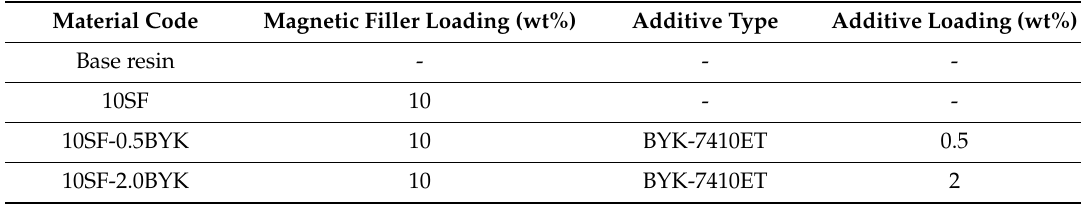
Table 1. Materials characterized by rheological